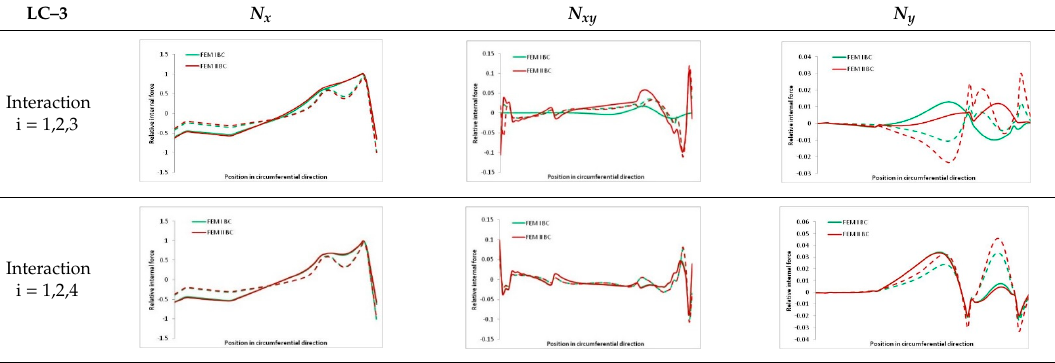
Table 17. Internal forces in LC–3 beam under the load corresponding to the first failure and the load-carrying capacity.